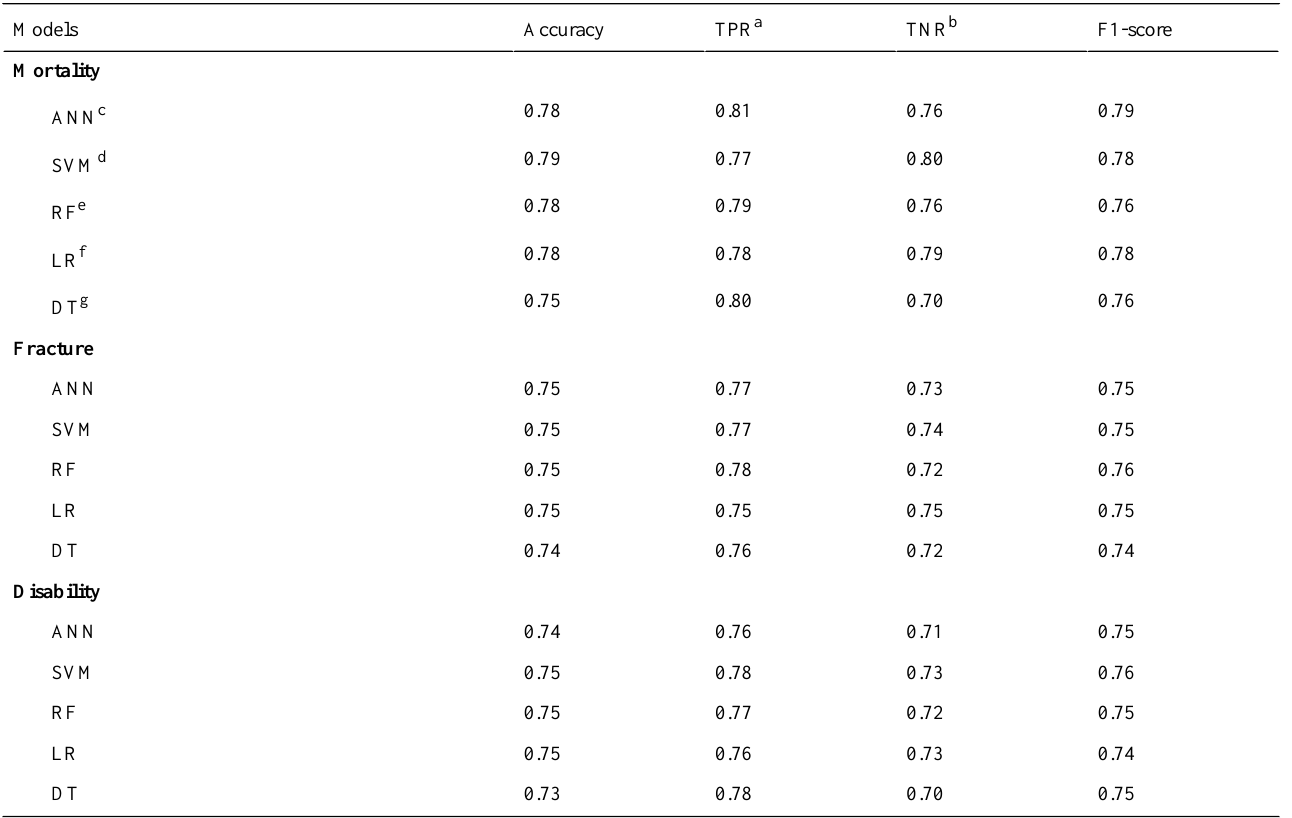
Table 5. Prediction results of models using a 10-fold